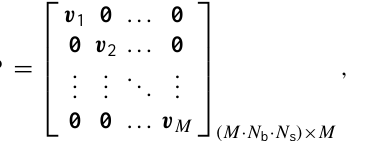
− 1 (cid:16) y − H( x b )